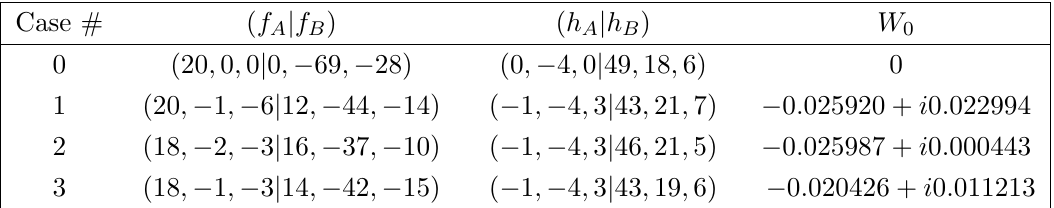
Table 1 . The (cid:13)ux integer choices and initial W 0 (found from solving D I W (cid:13)ux = 0 for I 2 f (cid:28); z i g ) for all four cases we studied. The values of eq. (3.5) were chosen such that the full potential V ( z i ; (cid:28); T ) of Case 1 has a Minkowski supersymmetric